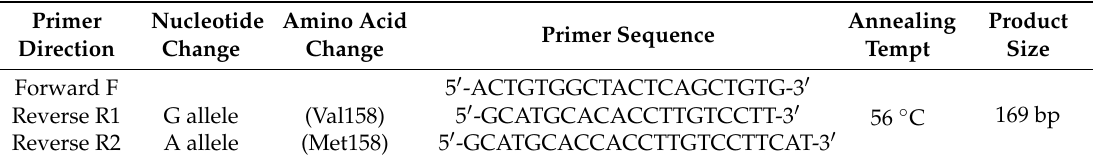
Allele-specific polymerase chain reaction (AS-PCR) primers for COMT (Val158Met)